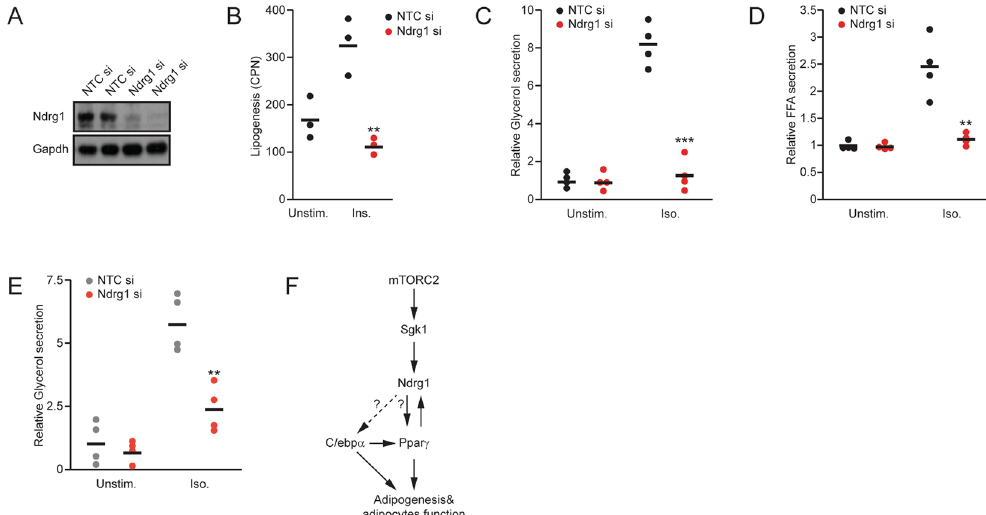
Figure 5. Ndrg1 promotes lipolysis independent of its impact on adipocyte differentiation. ( A ) Western blot for the indicated proteins in differentiated 3t3l1 cells transfected with control or Ndrg1 siRNA. ( B ) Lipogenesis rate in control siRNA and Ndrg1 siRNA transfected cells (Ndrg1 si), unstimulated (unstim.) or upon insulin (Ins.) stimulation. ( C ) Relative glycerol and ( D ) FFA levels in medium from differentiated 3t3l1 control cells or Ndrg1 siRNA-treated cells stimulated with control medium or Iso. ( E ) Relative glycerol levels in adipocytes differentiated from primary stroma-vascular cells isolated from subcutaneous fat pads and transfected with non-targeted control (NTC) or Ndrg1 siRNA. Each data point represents a biological replicate. Stars indicate significance for given parameters between control and Ndrg1-depleted cells. ( * P < 0.05, ** P < 0.01, *** P < 0.001 according to ANOVA followed by the Post hoc Tukey test). ( F ) Model of Ndrg1 action in adipocytes. mTORC2 activates Sgk1 kinase, which phosphorylates Ndrg1 on T346. Phosphorylated Ndrg1 increases expression of Ppar γ through an unknown mechanism to promote adipogenesis and adipocyte function. In a positive feedback loop, Ppar γ also promotes Ndrg1 expression and stability. Additionally, Ndrg1 promotes C/Ebp α phosphorylation, which might influence its